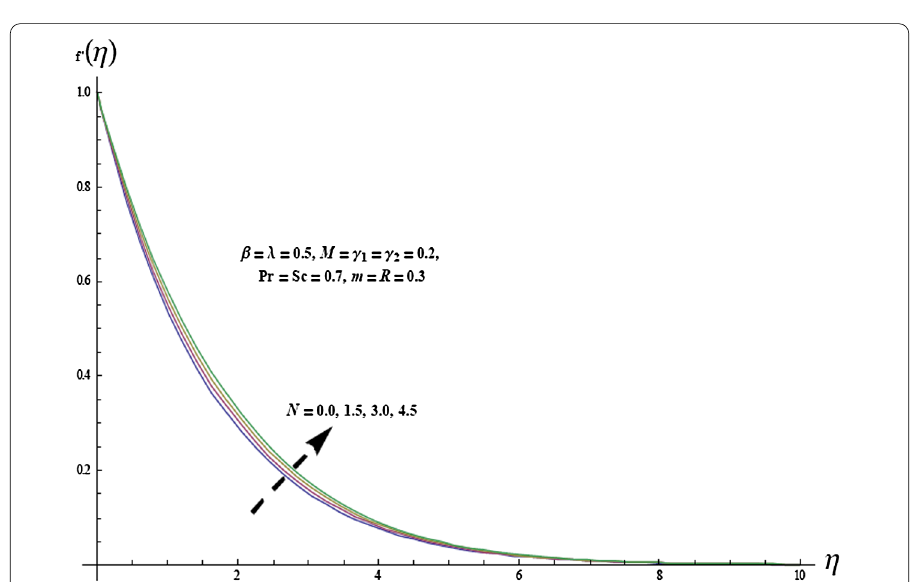
Figure 4 Variation of λ on f (cid:2) ( η ).